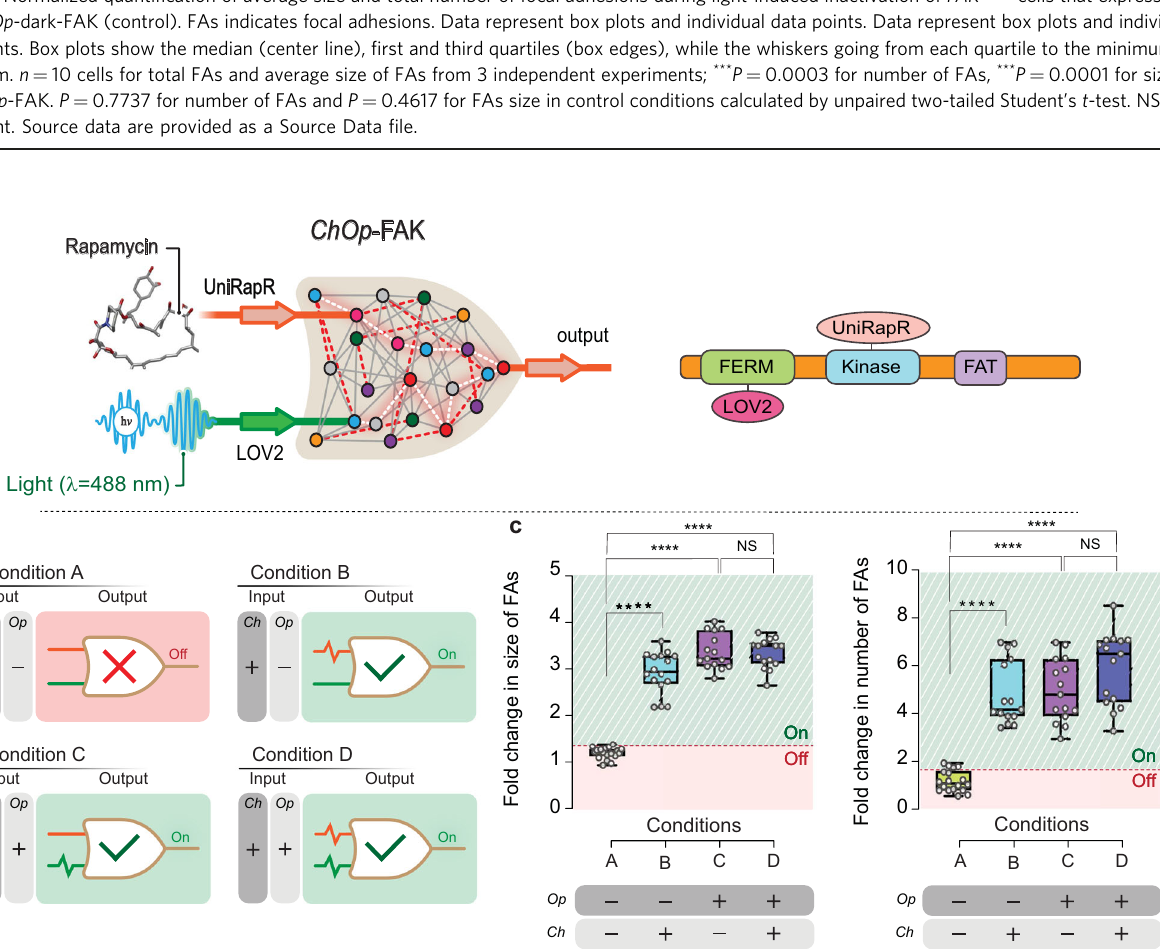
Fig. 7 Design and functionality of ChOp -FAK. a Left, schematic representation of ChOp -FAK. Validated Ch and Op modules were assembled to construct ChOp -FAK. Right, domain organization of ChOp -FAK. b Combinations of tested input conditions and the respective outputs. For Ch input, ChOp -FAK- expressing FAK − / − cells were treated with 50 nM rapamycin for 30 min. For Op input, dark and lit mutants of LOV2 were used to mimic the dark and light conditions, respectively. c Quanti fi cation of average size and total number of focal adhesions in FAK − / − cells expressing linker optimized ChOp -FAK. Pink box indicates inactivation and green box indicates activation of FAK. Data were normalized to Condition A. Focal adhesion (FAs) indicates focal adhesions. Data represent box plots and individual data points. Data represent box plots and individual data points. Box plots show the median (center line), fi rst and third quartiles (box edges), while the whiskers going from each quartile to the minimum or maximum. n = 18 cells for Condition A, n = 16 cells for Condition B, n = 15 cells for Conditions C and D from 3 independent experiments. For total number of FAs, **** P = 4.3 × 10 − 12 for A and B, **** P = 1.07 × 10 − 12 for A and C, **** P = 1.18 × 10 − 13 for A and D, P = 0.08 for C and D. For Average size of FAs, **** P = 1.2 × 10 − 16 for A and B, **** P = 7.25× 10 − 23 for A and C, **** P = 5 × 10 − 21 for A and D, P = 0.768 for C and D conditions calculated by unpaired two-tailed Student ’ s t -test. NS, not signi fi cant. Source data are provided as a Source Data fi optimized the modeled chimeric structures using Chiron 33 and Gaia 34 and sub- whether the identi fi ed insertion region is allosterically connected to the target site. We excised the S264 – S265 peptide bond and inserted LOV2 with the J α helix either sequently employed constant-temperature, all-atom DMD simulations at 0.5kcal/ in a folded or unfolded conformation to represent dark and lit states, respectively. mol·k B . The inserted LOV2 domain remained folded as the employed DMD We employed Modeler-9v14 29 to model chimeric FAK-LOV2 complex structures. simulation temperature was less than protein folding transition temperature. We optimized the relative orientation of the LOV2 domain with respect to FAK by For each model, we generated 40 candidates and selected the model with the least DMD. We monitored the convergence of energy distributions for the protein modeler objective function. When generating the models, we imposed restraints on during the simulations to evaluate its equilibration. We repeated each DMD FAK to avoid conformational changes due to LOV2 insertion. We initially